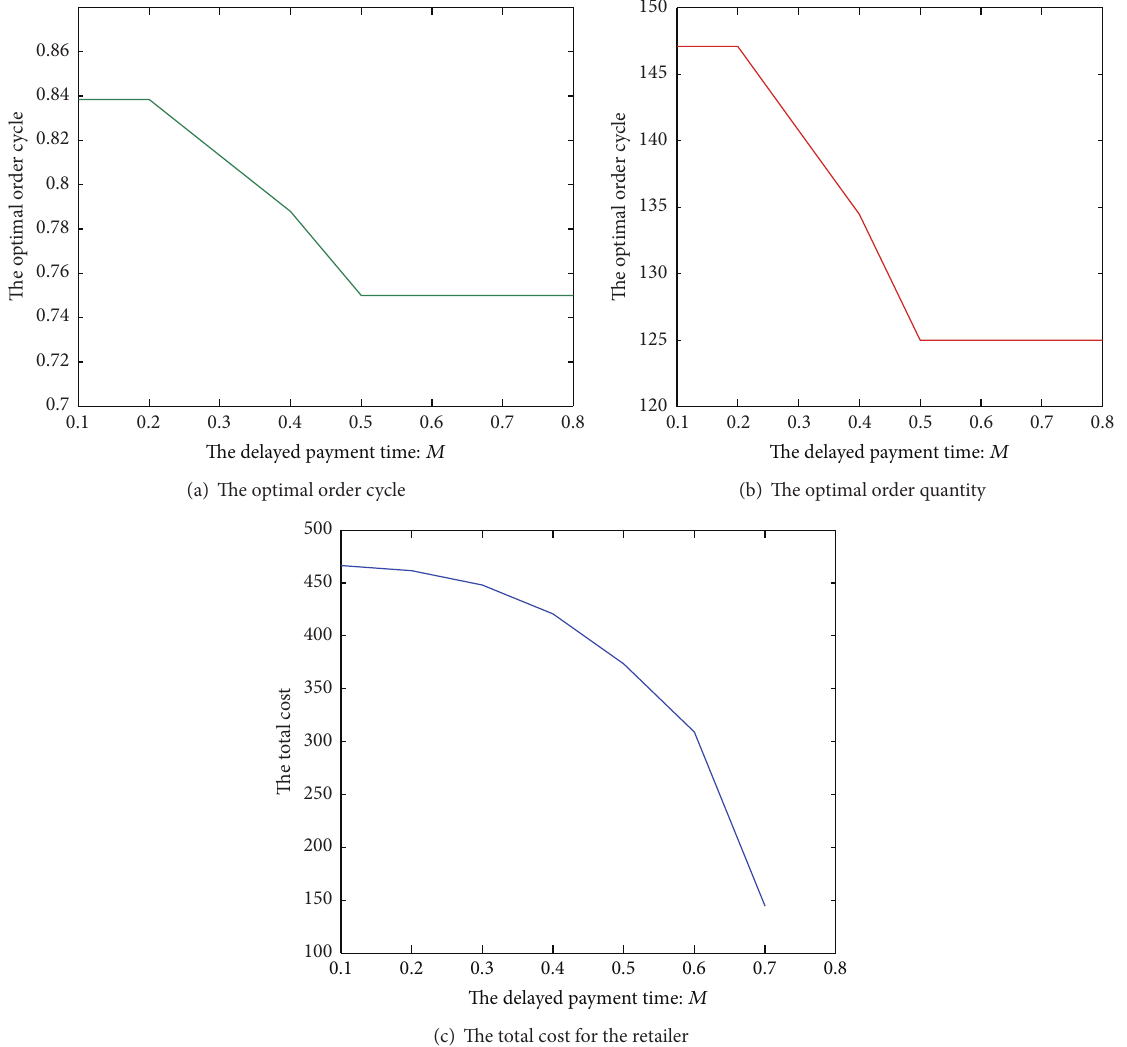
Figure 8: The impact of the changes of the parameter 𝑀